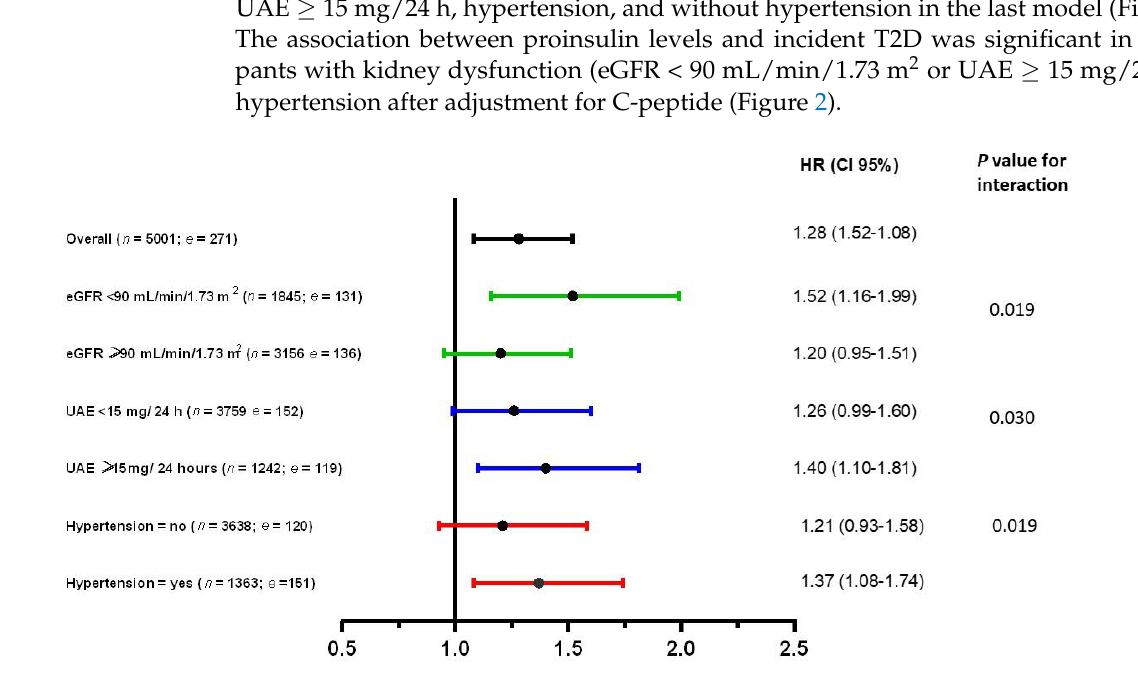
Figure 2. Association between proinsulin and risk of diabetes in the overall population and stratified by selected characteristics ( n = number of participants, e = number of events). Multivariable hazard ratios (95% confidence intervals) for risk of incident T2D are expressed per log unit increase proinsulin levels. Hazard ratios (95 CIs) were derived from Cox proportional hazards regression models adjusted for age, sex, smoking status, alcohol consumption, BMI, family history of diabetes, triglycerides, total cholesterol, HDL cholesterol, eGFR, urinary albumin excretion, glucose, and insulin and C-peptide. BMI: body mass index; HDL: high-density lipoprotein; eGFR: estimated glomerular filtration rate.